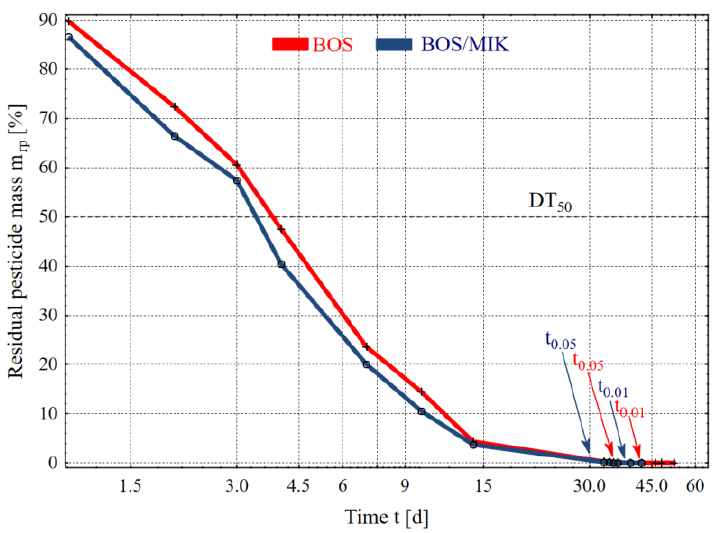
Figure 3. Mass deposition (% residual BOS mass) in non-microbial (BOS) and microbial-enriched (BOS/MIK) wastewater passed through the hydrophytic bed throughout the study period.